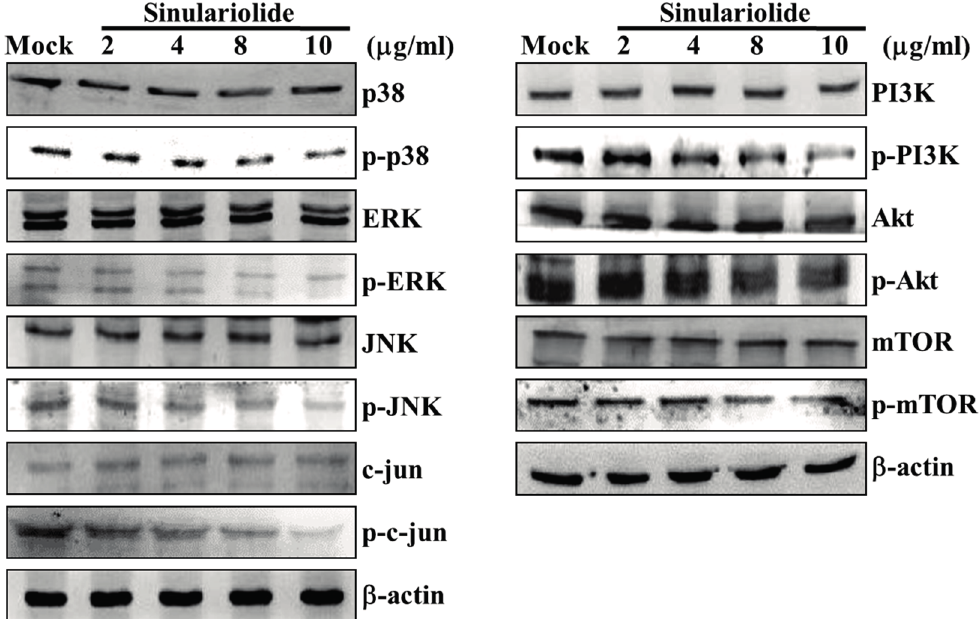
Figure 4. The effects of sinulariolide on MAPKs and PI3K/Akt signaling pathways.